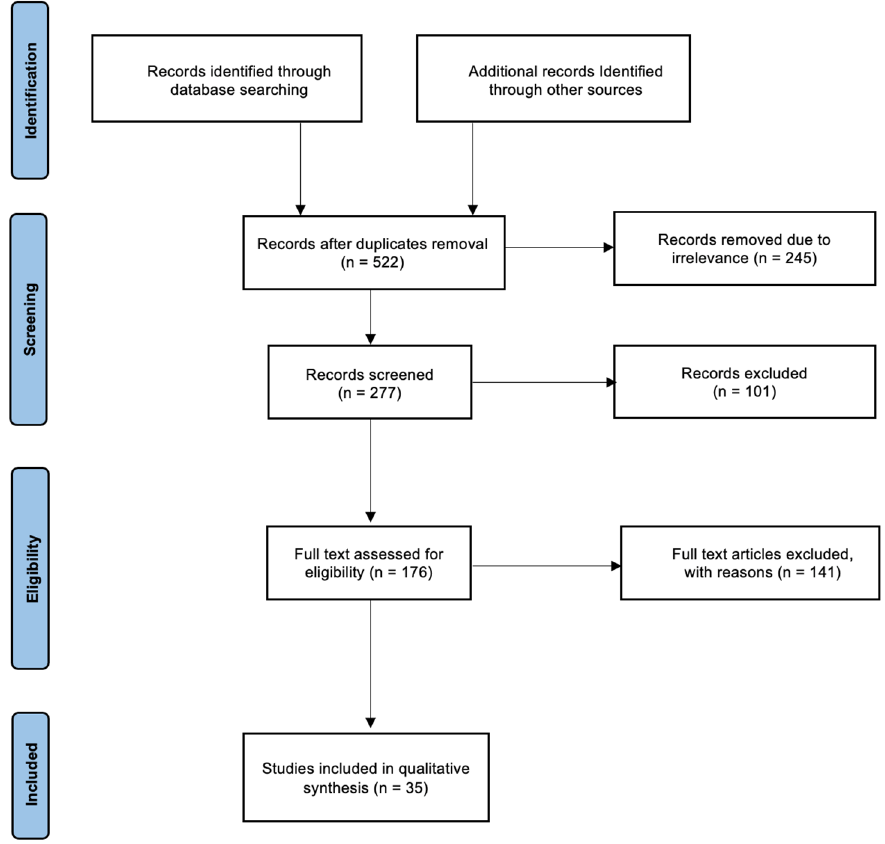
Figure 2. PRISMA flow diagram.